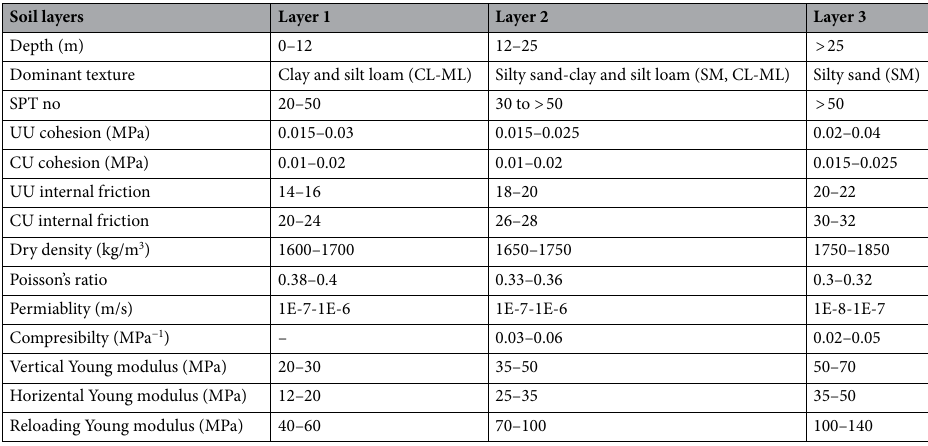
Table 1. Geological properties of soil